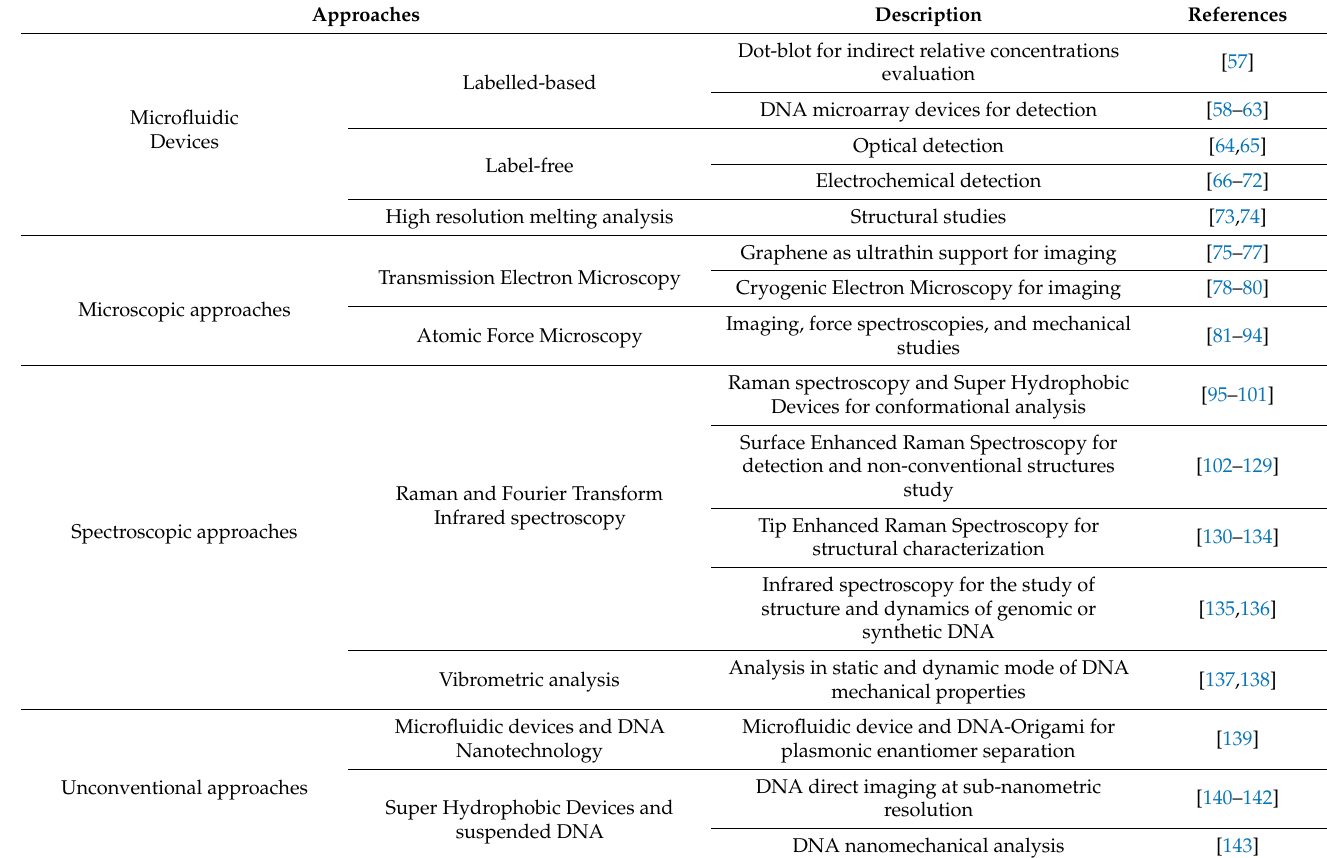
Table 1. Summary of the approaches reported in this review with their application to DNA studies and the related references.